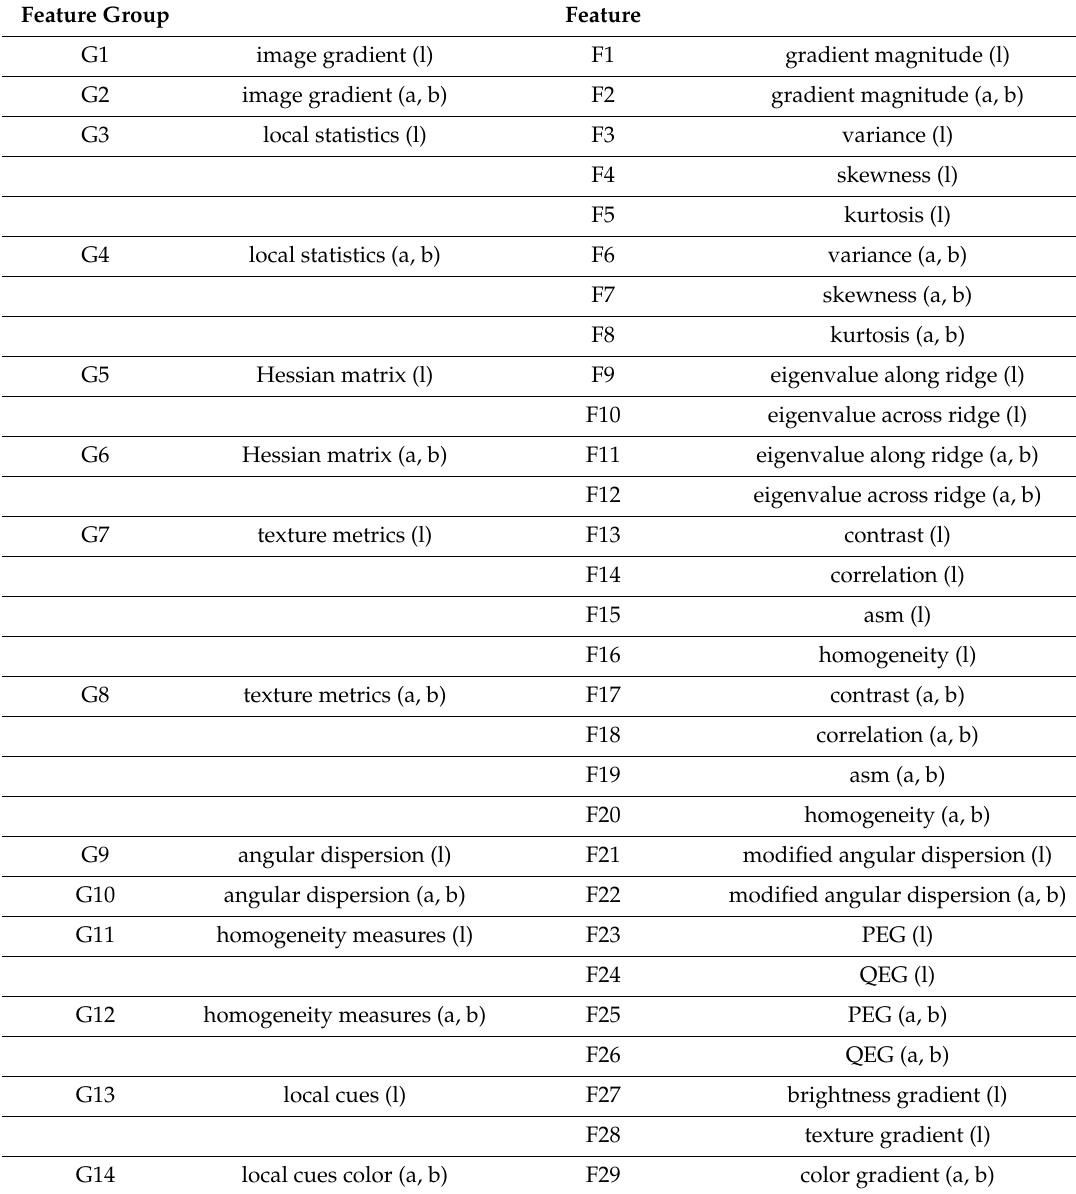
Table 2. Overview of features and respective feature groups considered for boundary